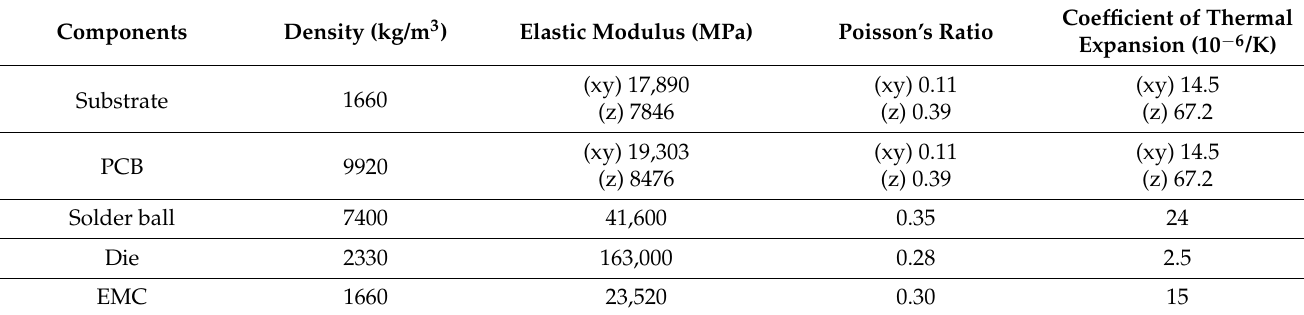
Table 2. Material properties of components in the BGA package Table 3. Anand Parameters of Sn3.0Ag0.5Cu solder [18].